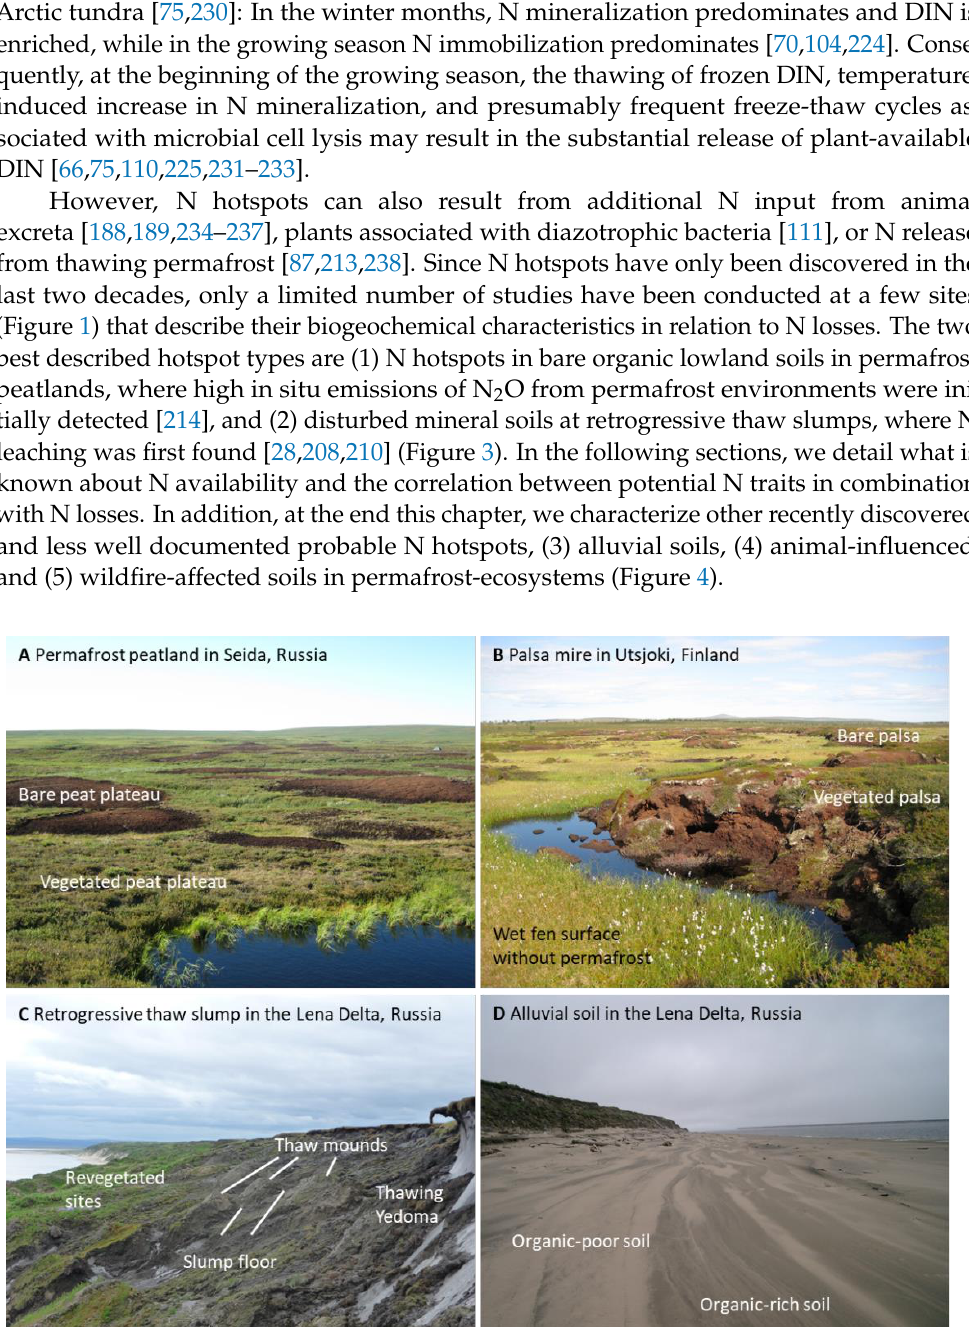
Figure 4. Hotspots of high N availability in a schematic permafrost landscape of a tundra ecosystem with ( A ) permafrost peat plateaus and palsas with bare peat surfaces in the discontinuous perma- frost zone; hillslope thermokarst landscapes such as ( B ) retrogressive thaw slump in the continuous and ( C ) thermo-erosion gully in the discontinuous permafrost zone, ( D ) alluvial soils in the transi- tion between terrestrial and aquatic ecosystems, and the occurrence of ( E ) animal-influenced soils and ( F ) wildfire throughout ecosystem. Blue arrows indicate known gaseous (N 2 O, NO, HONOH)